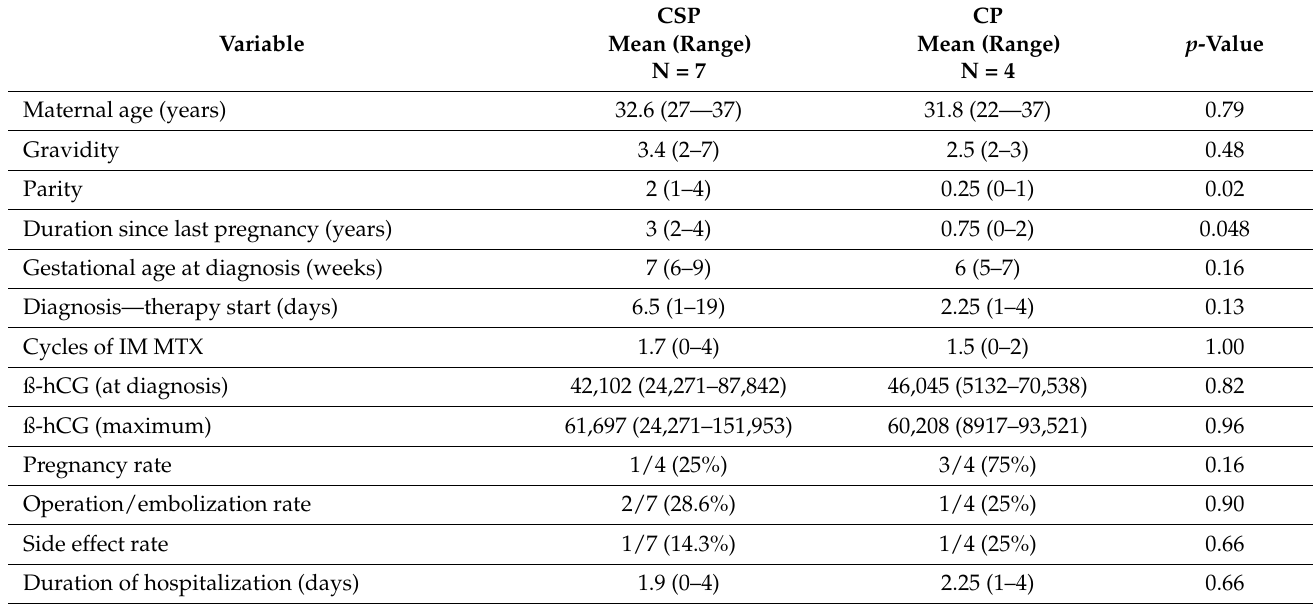
Table 2. Comparison between cesarean scar pregnancies and cervical